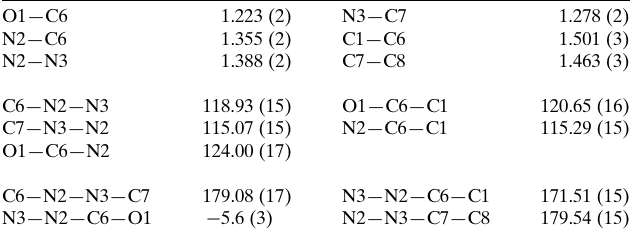
Table 2 Selected geometric parameters (A˚ , (cid:3) ) for (II).